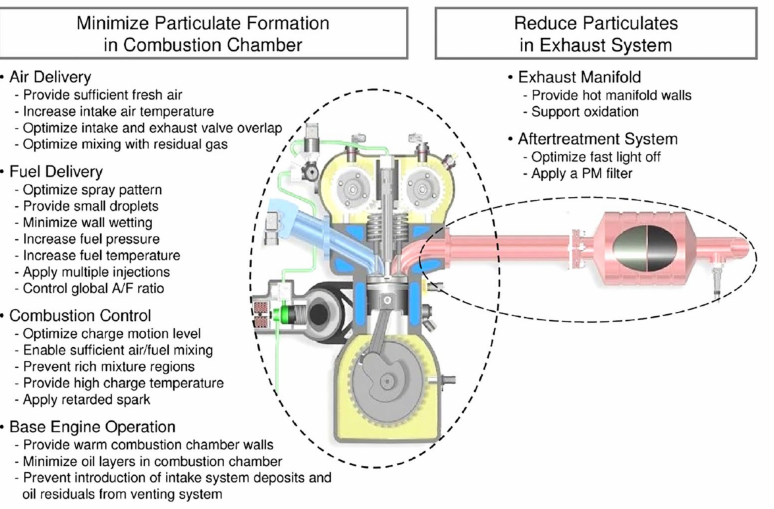
Figure 3. Strategies to minimize particulate emission from gasoline engines. Reproduced with permis- sion of reference